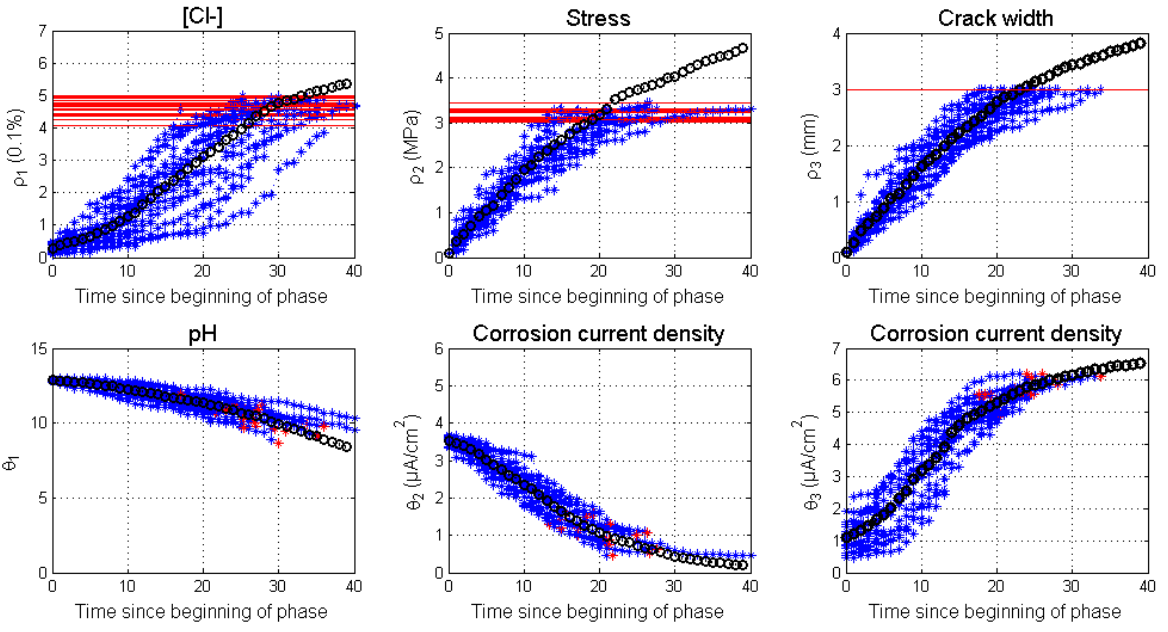
Figure 2. Simulation of the degradation indicators for each phase (time is expressed in years for all